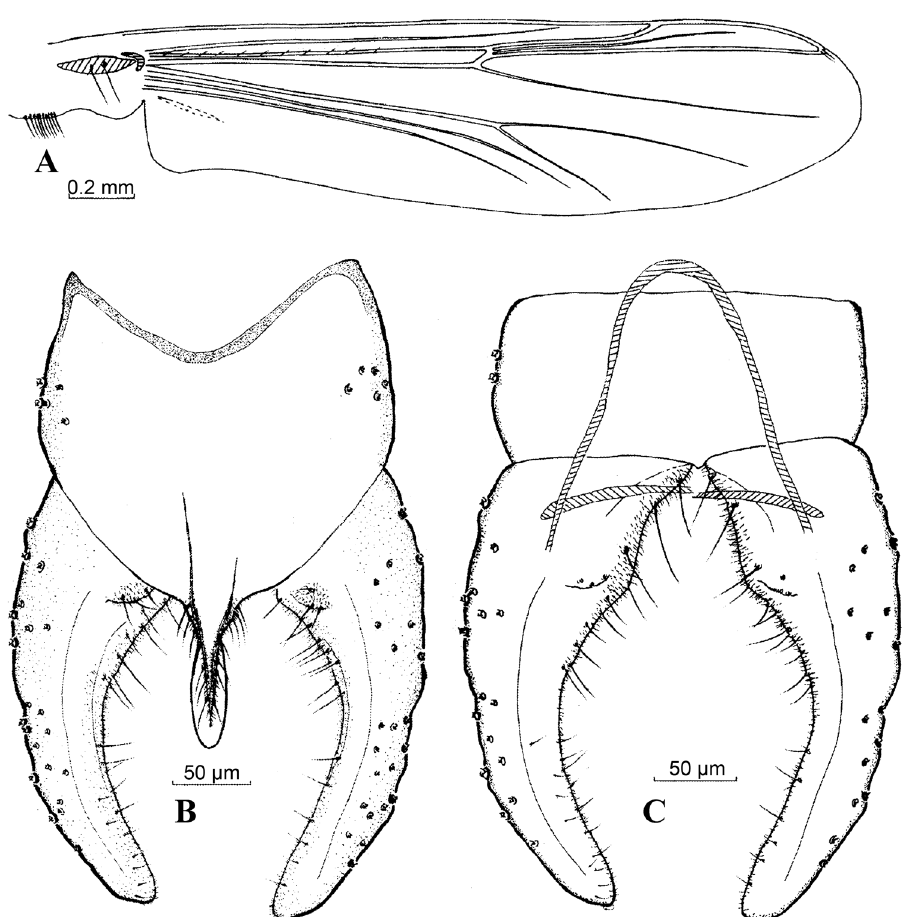
Figure 3. Harnischia curtilamellata . A Wing; Hypopygium: B (dorsal) C (ventral).